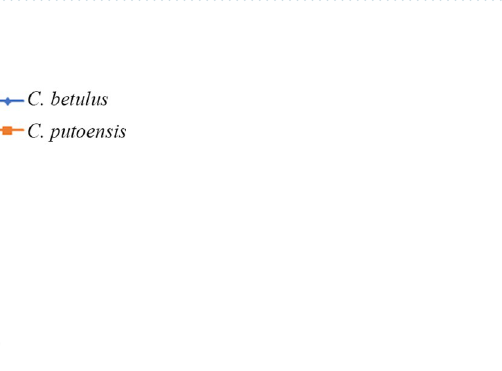
Table 1. The damaged areas (percentage) of the leaves of Carpinus betulus and Carpinus putoensis at different time points of NO